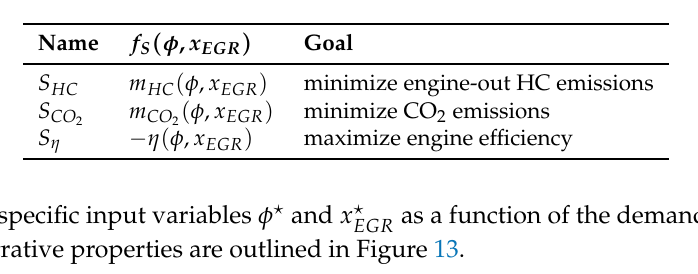
Table 10. The cost functions f S of the three strategies